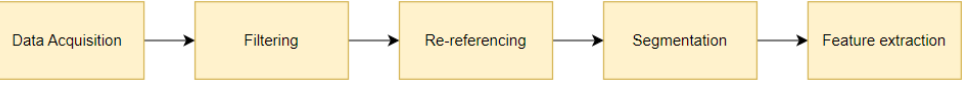
Figure 1. Signal preprocessing path with feature extraction.